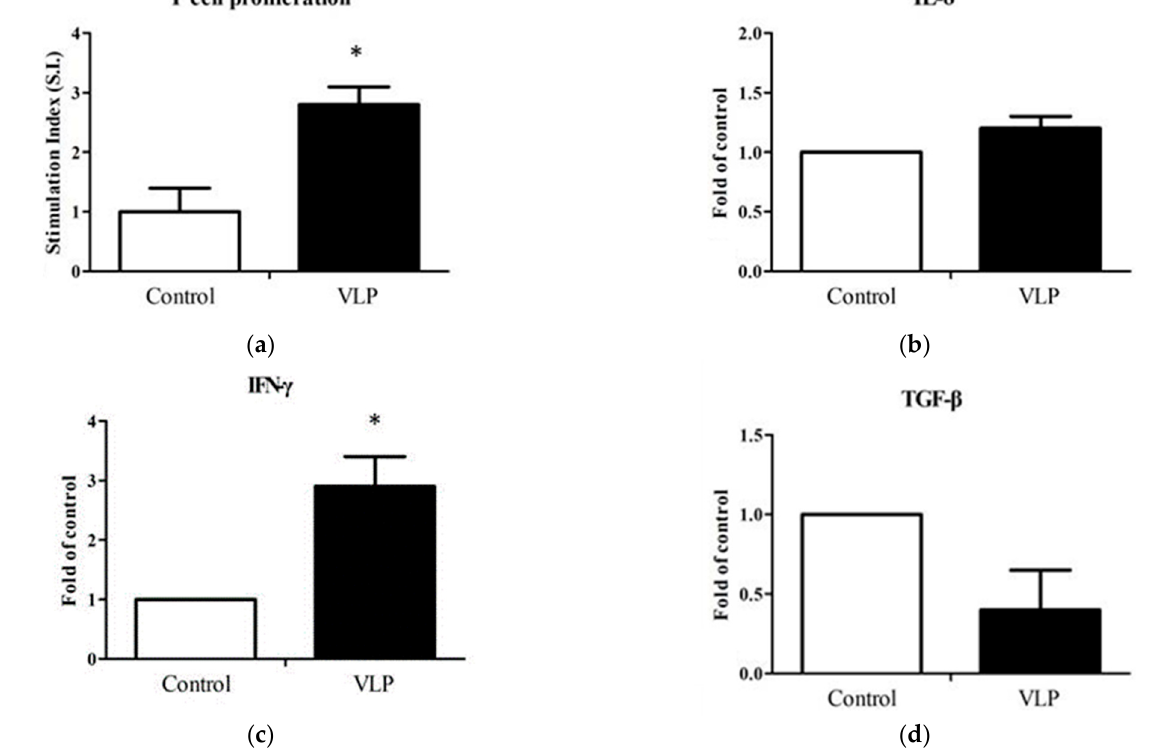
Figure 5. Immunogenic response of pigeons to PiCV rCap-VLPs vaccination. Two groups were observed in the study. The control group was immunized with saline supplemented with W/O/W adjuvant, while the VLP group was immunized with PiCV rCap-VLPs. ( a ) Proliferation of T-cells was determined by isolating lymphocytes from spleen, and subsequently incubating with VLPs protein for 72 h. Quantifications of the expression of each cytokines ( b ) IL-8, ( c ) IFN- γ , and ( d ) TGF- β -2 were performed using RT-PCR, with pigeon β -actin as internal control. Significant difference ( p < 0.05) was notated as *.